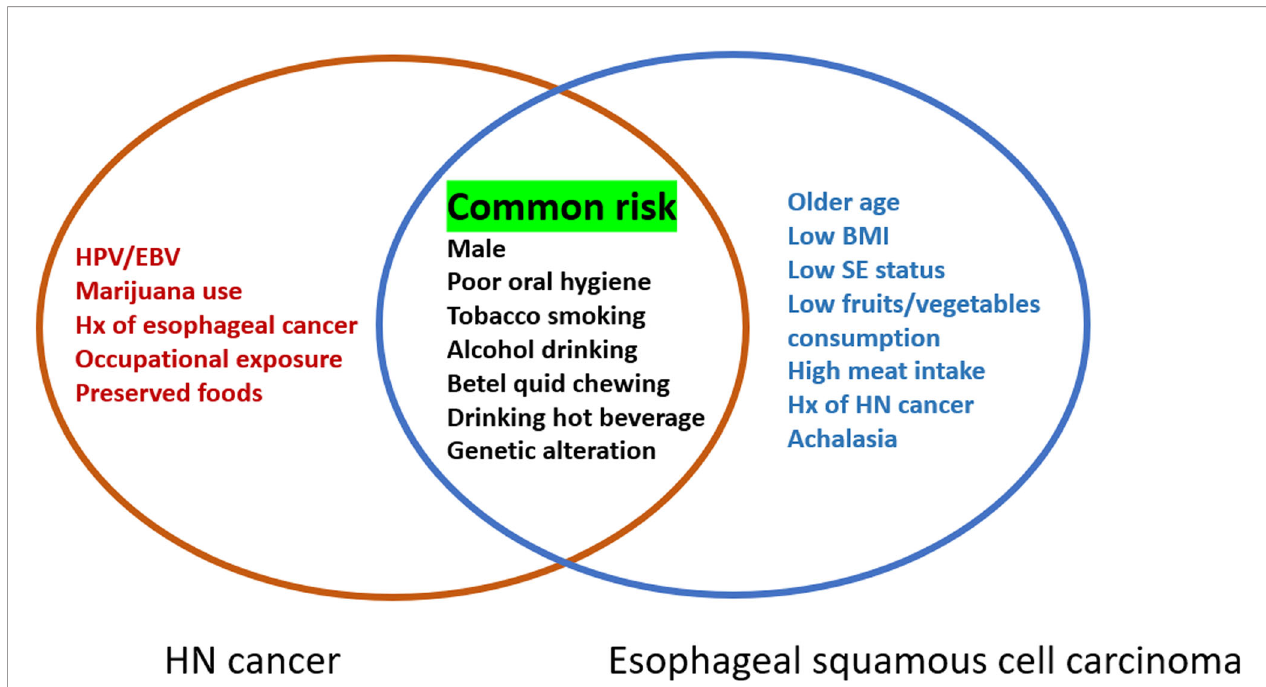
FIGURE 1 | Risk factors for head and neck cancer and esophageal squamous cell carcinoma. HPV, human papillomavirus; EBV, Epstein-Barr virus; Hx, history; BMI, body mass index; SE,